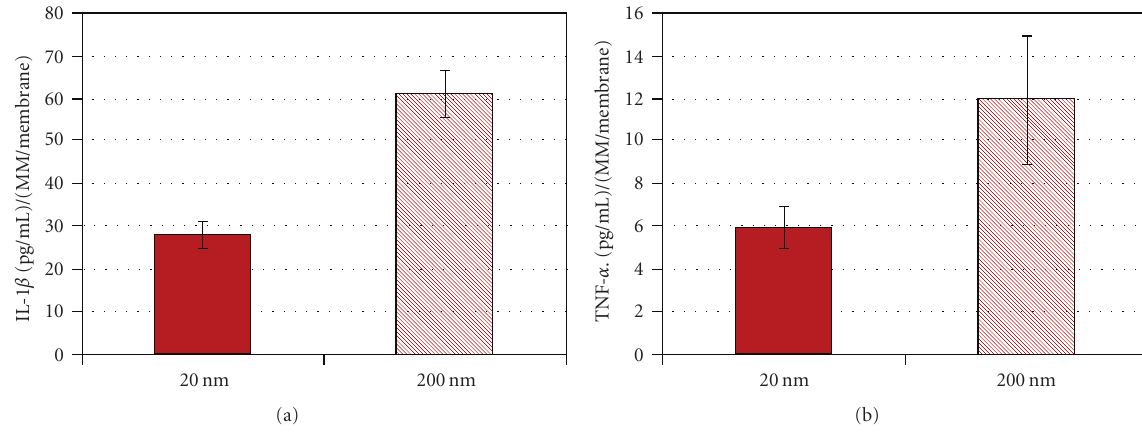
Figure 3: Cytokines released by MM after 24h of incubation with 20nm- and 200nm-pore alumina. Data represents the mean ± SE from experiments using blood from 7 di ff erent donors. A significant di ff erence between the two materials was observed for IL-1 β release ( P < . 001), as well as a clear tendency for TNF- α